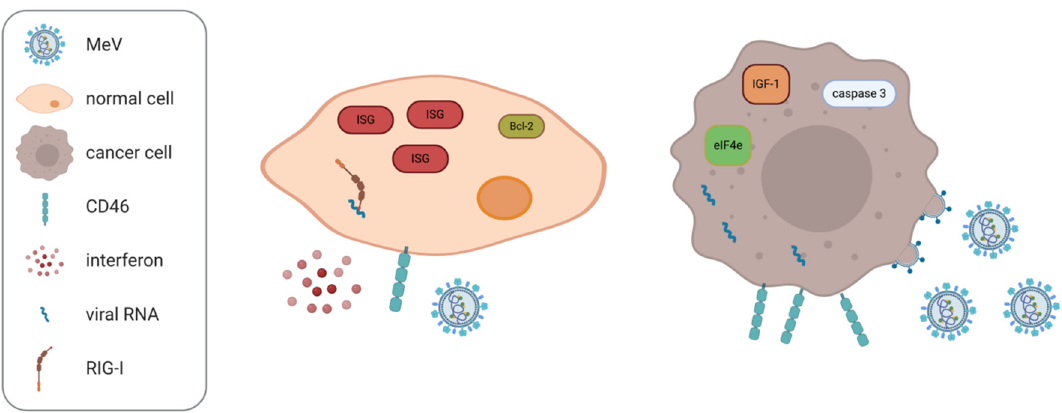
Figure 2. Measles virus oncotropism. Oncolytic measles virus (MeV) does not replicate productively in normal cells (left) in contrast to cancer cells (right). This oncotropism has been associated with differential expression of i.a. the depicted host cells factors. ISG: interferon-stimulated gene; RIG-I: retinoic acid-inducible gene I; IGF-1: insulin-like growth factor-I.